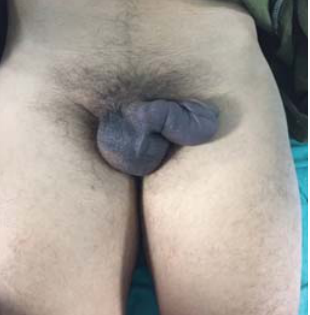
Figure 1. Penile deformity in a patient with penile fracture (“eggplant”